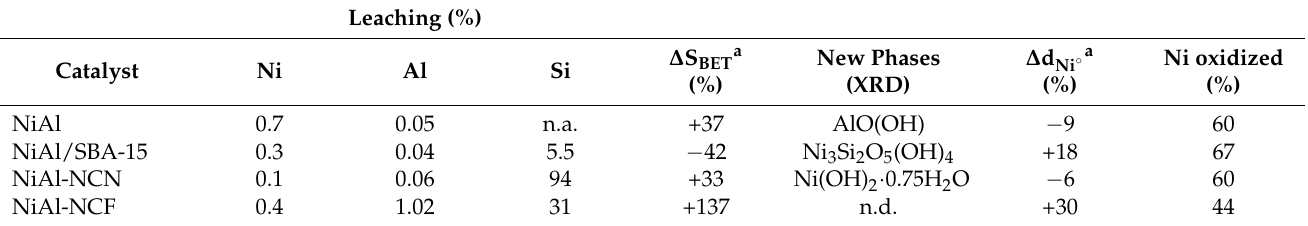
Table 4. Physico-chemical properties of glycerol APR exhausted catalysts.